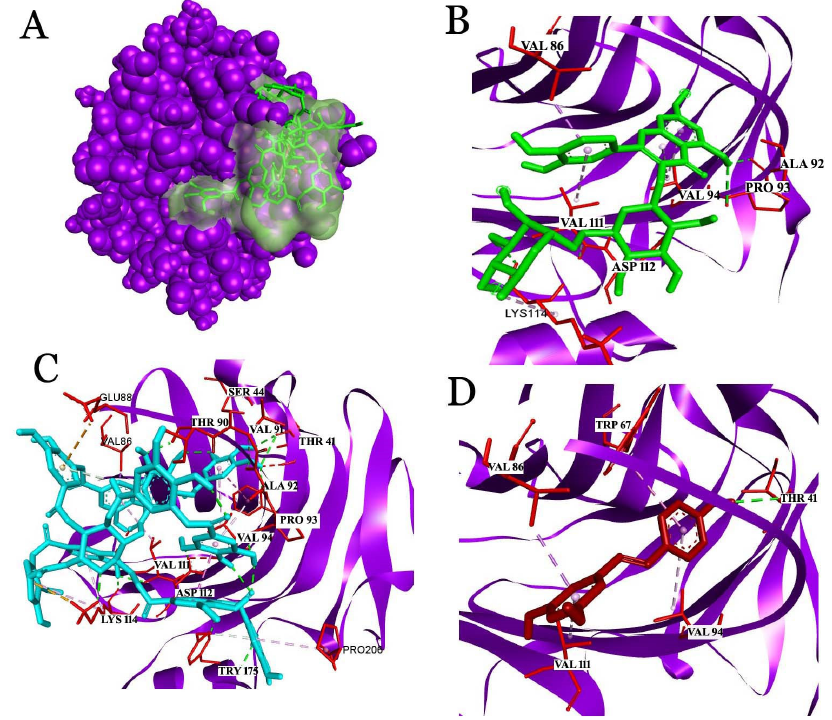
Figure 3. Interactions of ligands with the key residues of C-reactive protein (CRP). ( A ) The surface view represents the predicted binding pocket (green color) of the CRP; ( B ) the interaction of rutin with CRP; ( C ) the interaction of tannic acid with CRP; ( D ) the interaction of resveratrol with CRP.